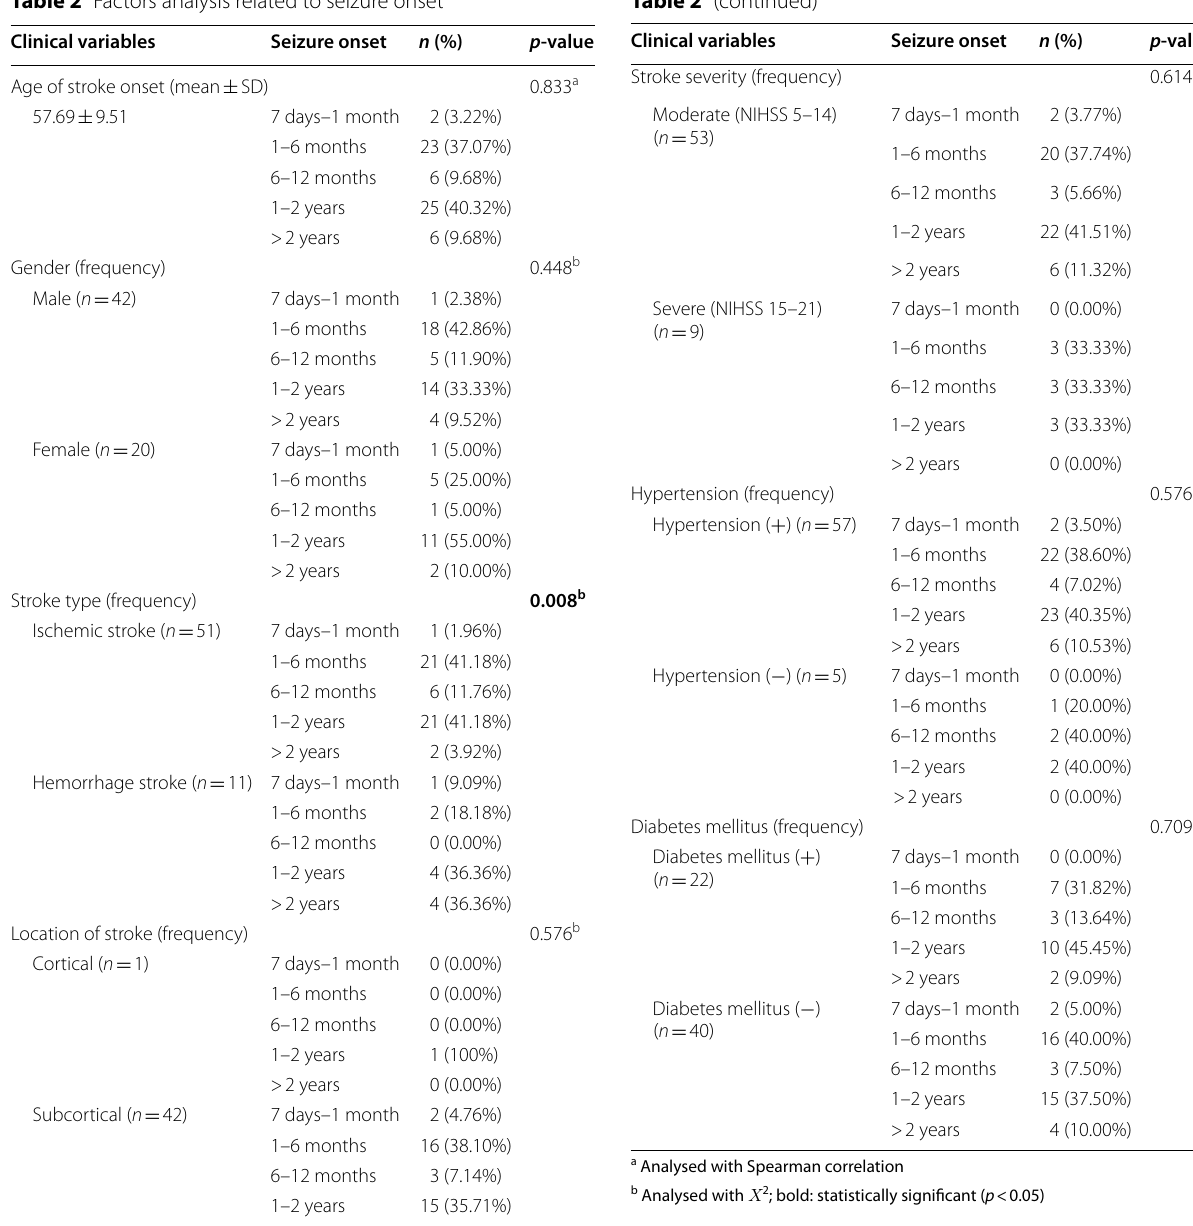
Table 2 Factors analysis related to seizure